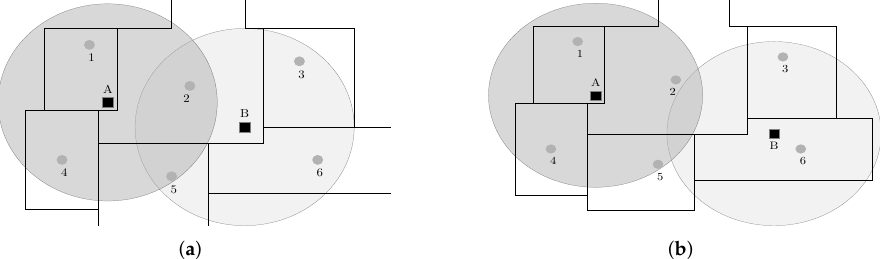
Figure 1. Hypothetical spatial distribution of health centers and their coverage zone in: ( a ) scenario 1; and ( b ) scenario 2; where “A” and “B” in both plots are the healthcare centers, whereas “1–6” are the • geographical zones, with and (cid:4) sketching a zone discrete center and a center location,